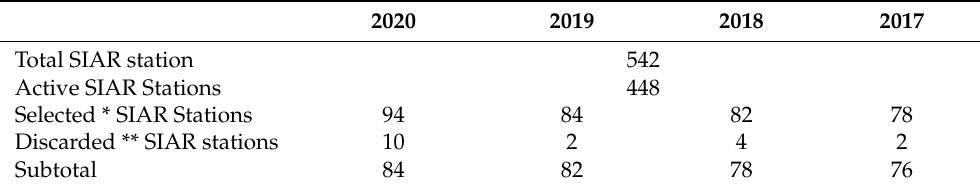
Table 1. SIAR stations and quality